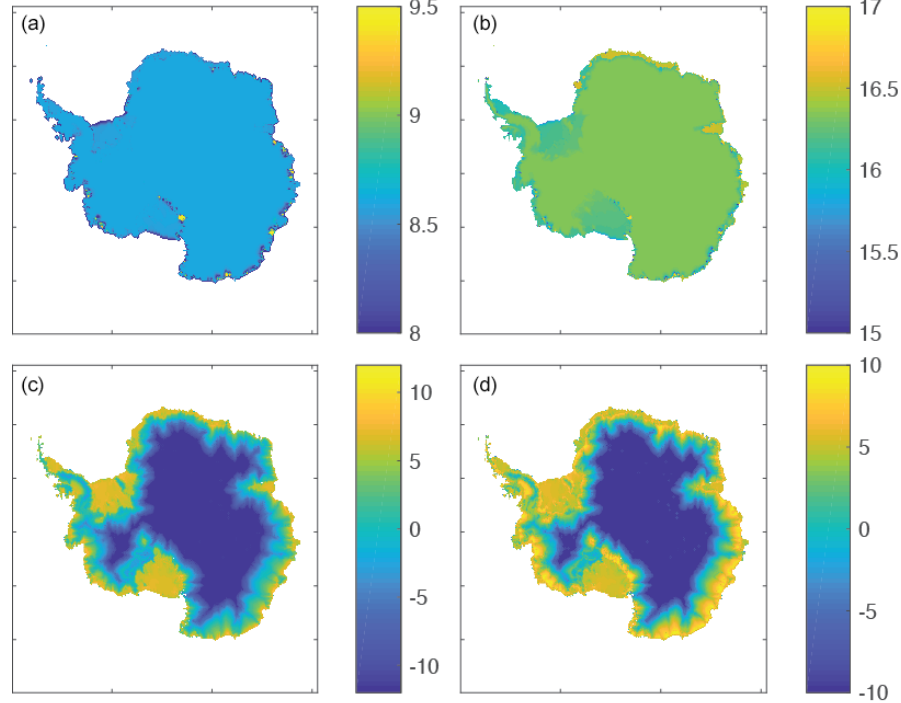
| , for the Antarctic Ice Sheet, where X i is the control variable δX i